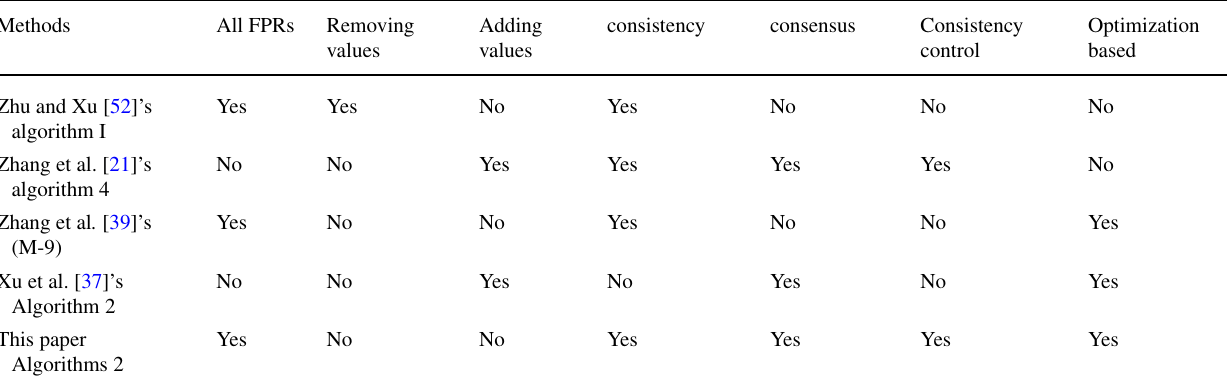
Table 2 A comparison of various consistency and consensus methods Methods All